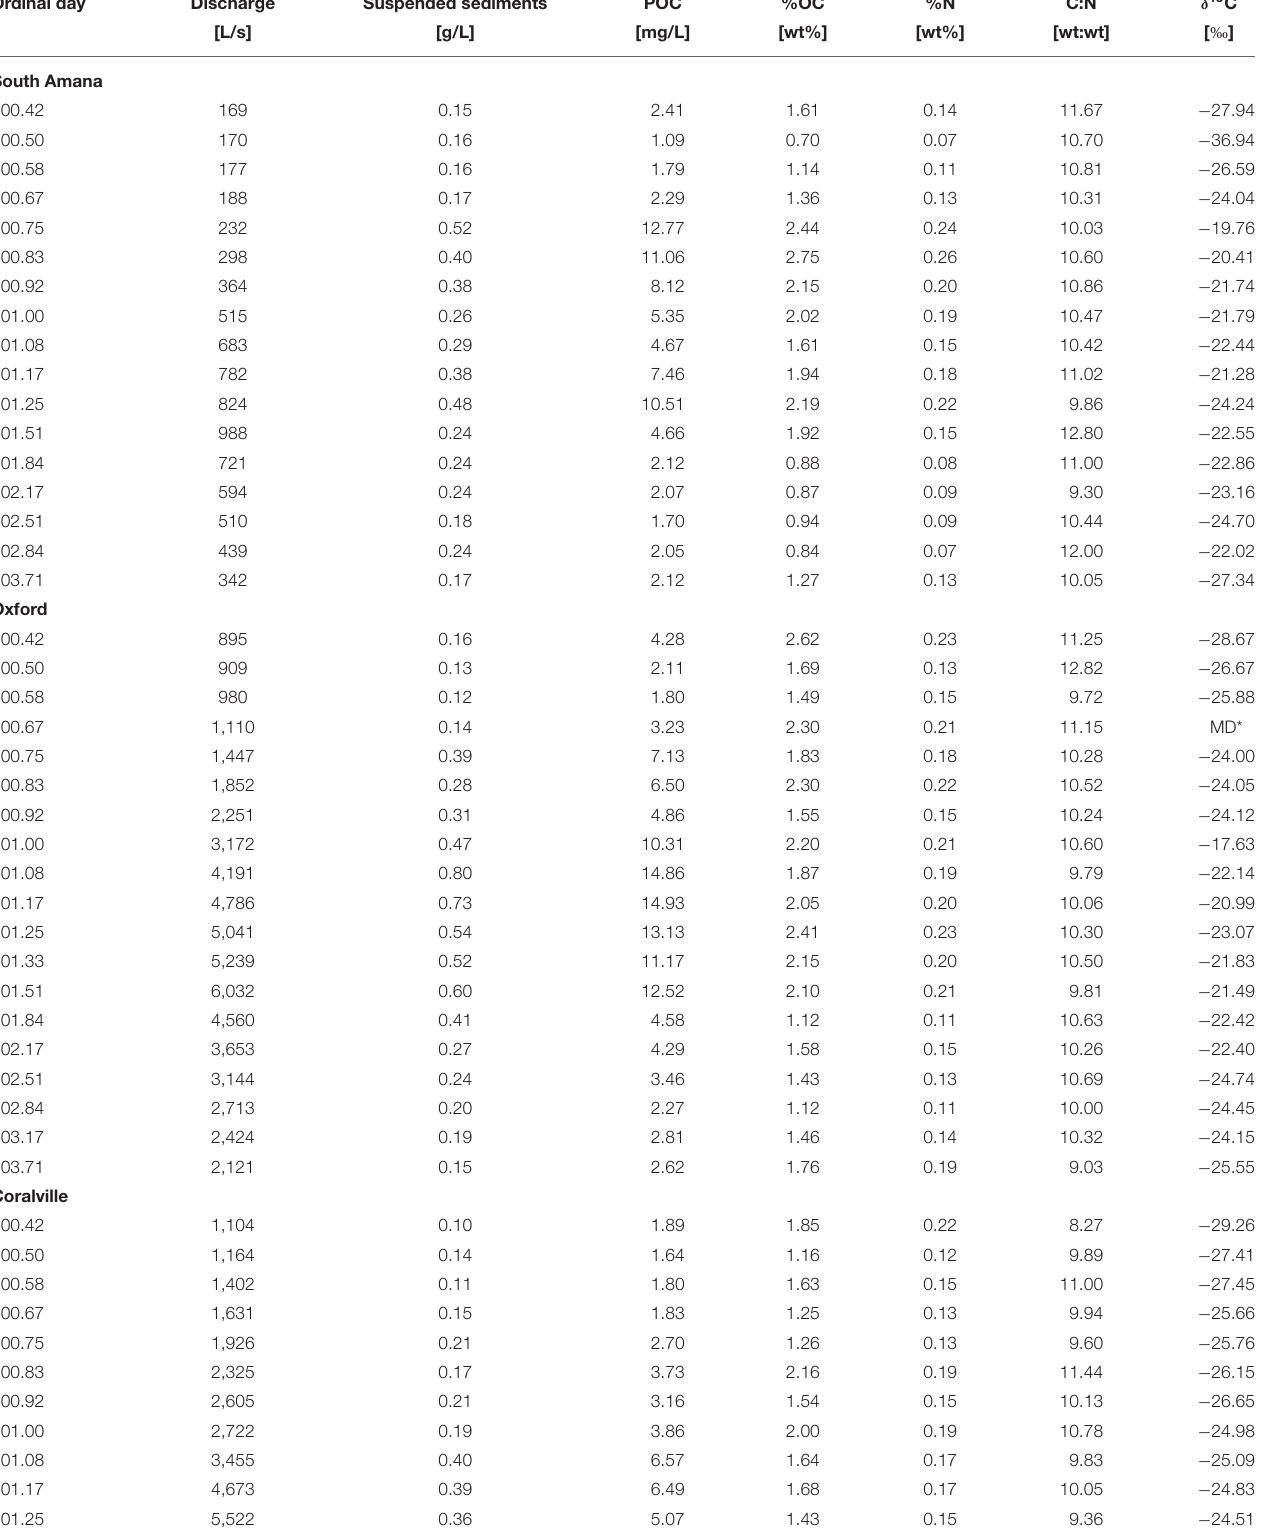
TABLE 3 | Storm characteristics, concentrations of sediment and POC, and bulk